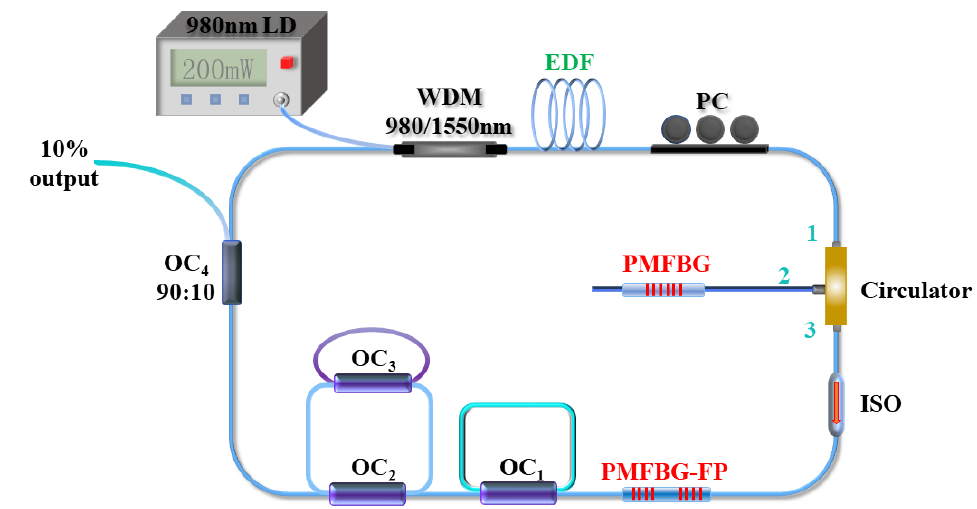
Figure 1. Experimental structure diagram of the proposed DW ‐ EDFL.